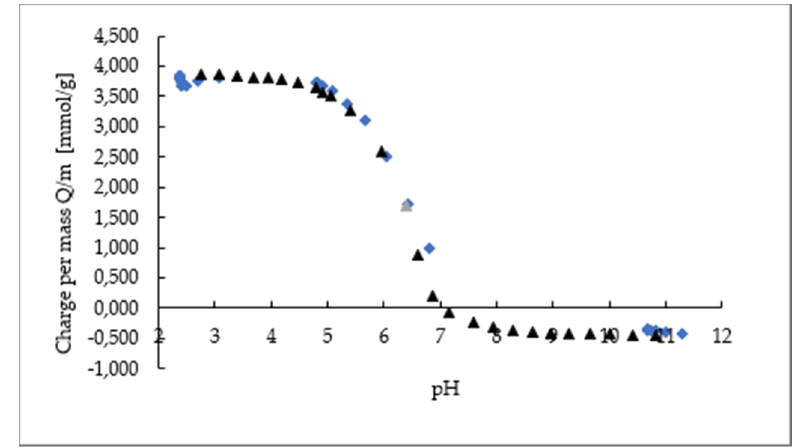
Figure 2. Potentiometric titration curves of chitosan: black curve, forward (from acidic to alkaline); blue curve, backward (from alkaline to acidic).